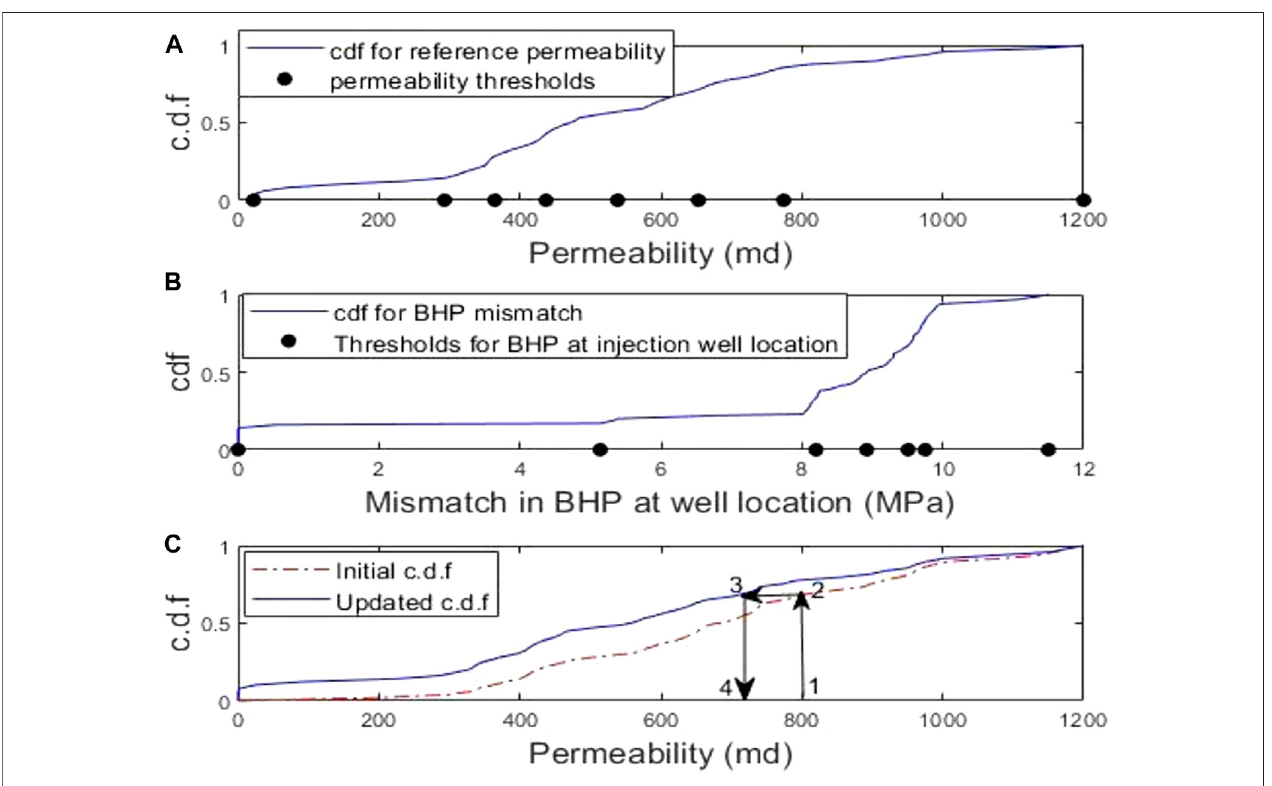
FIGURE12|(A) cumulativedisributionfunctionforpermeabilityforreferencemodel, andtheprimaryindicatorthresholdsretrieved forpermeabilitydistribution, (B) Indicator de fi nitions for Bottom -hole pressure (BHP) at injection well location, and (C) update of primary variable (permeability).